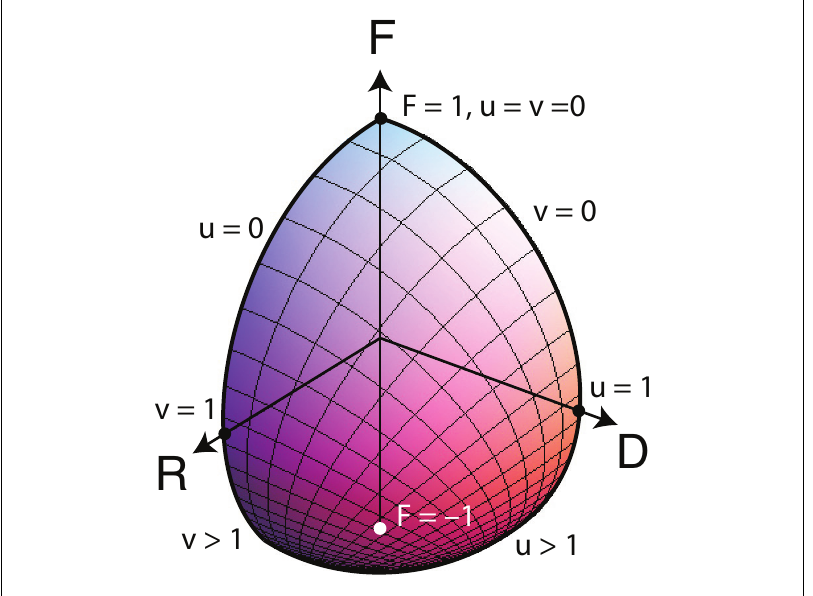
Figure 2. Lines of constant value of u , v on the surface of the generalized retardation sphere, two orthogonal sets of circles all passing through the point F = − 1 (hidden from view).